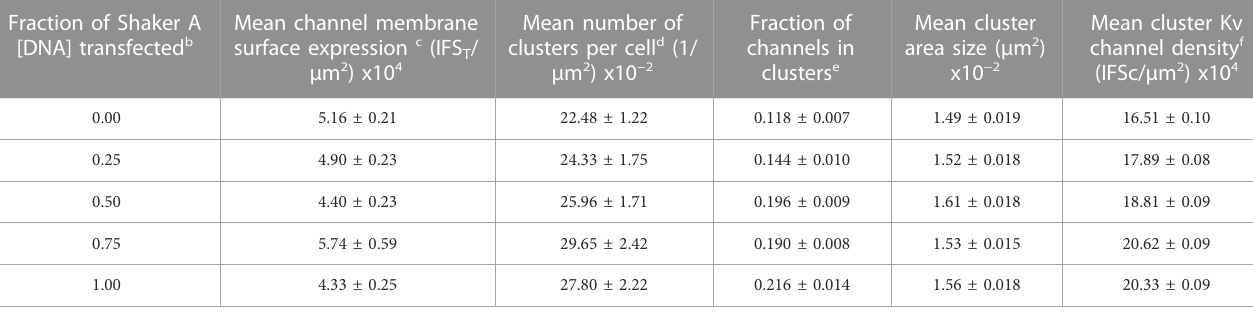
TABLE 1 The role of subunit hetero-oligomerization on PSD-95-mediated Shaker Kv channel clustering a . Fraction of Shaker A [DNA] transfected